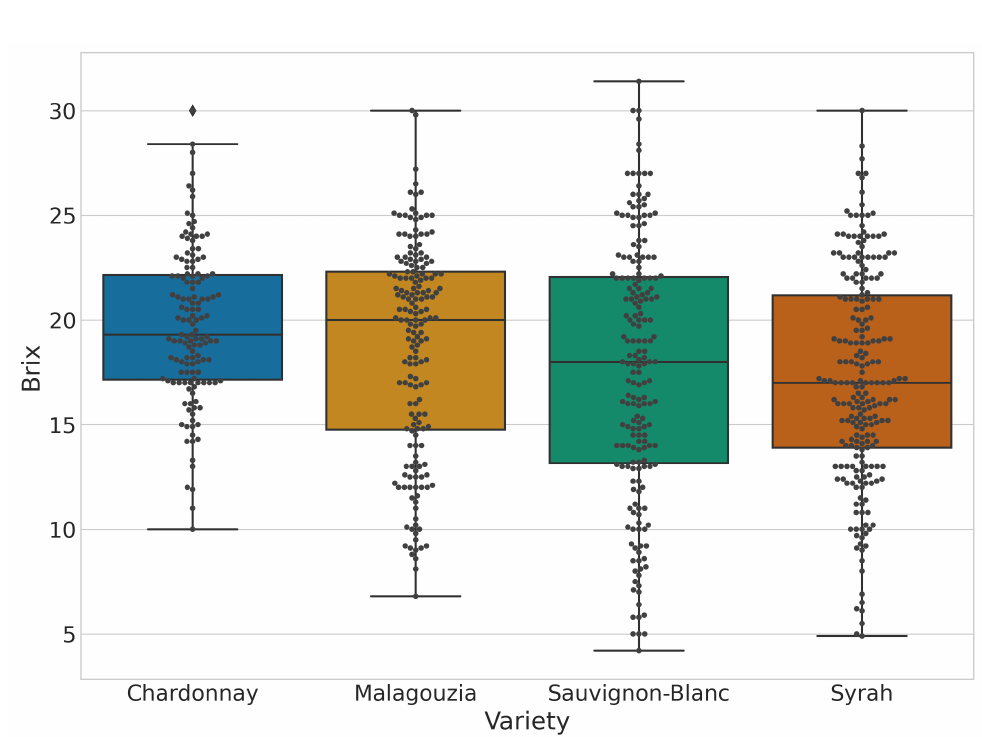
Figure 5. Box plot (overlaid with a swarmplot) of the °Brix content across the four different grape varieties; outlying values are denoted with a diamond